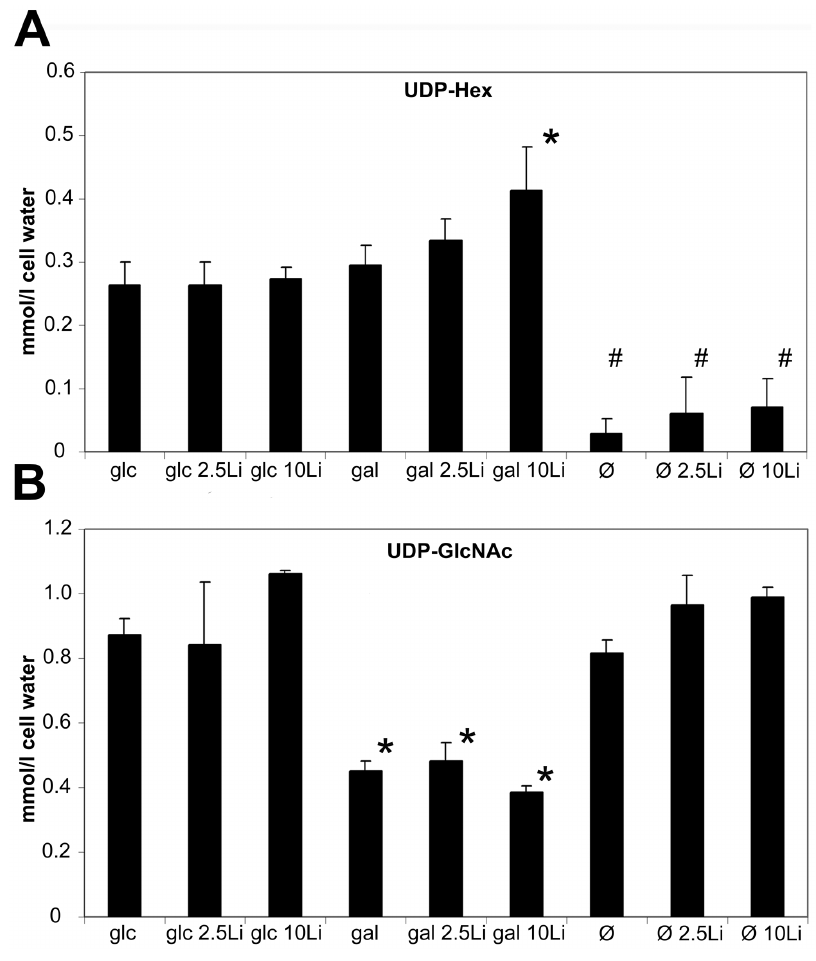
Figure 2. Lithium elevates UDP-Hexose content in galactose-grown Jurkat cells. ( A ) UDP-Hexose (UDP-Hex) [sum of UDP-Glucose (UDP- Glc) and UDP-Galactose (UDP-Gal)] levels from 5 mM glucose, 5 mM galactose treated or fasting cells, with 0, 2.5 or 10 mM Li treatment. After 48 hours incubation, UDP-Hex levels were measured using HPLC and expressed as mmol/cell water. Data are means 6 SD from at least 4 independent experiments. *P , 0.05 vs. control (glc), # P , 0.01 vs control (glc). ( B ) UDP-N-acetylglucosamine (UDP-GlcNAc) levels from samples pretreated as described above. UDP-GlcNAc levels were measured using HPLC and expressed as mmol/cell water. Data are means 6 SD from at least 4 independent experiments. *P , 0.01 vs. control